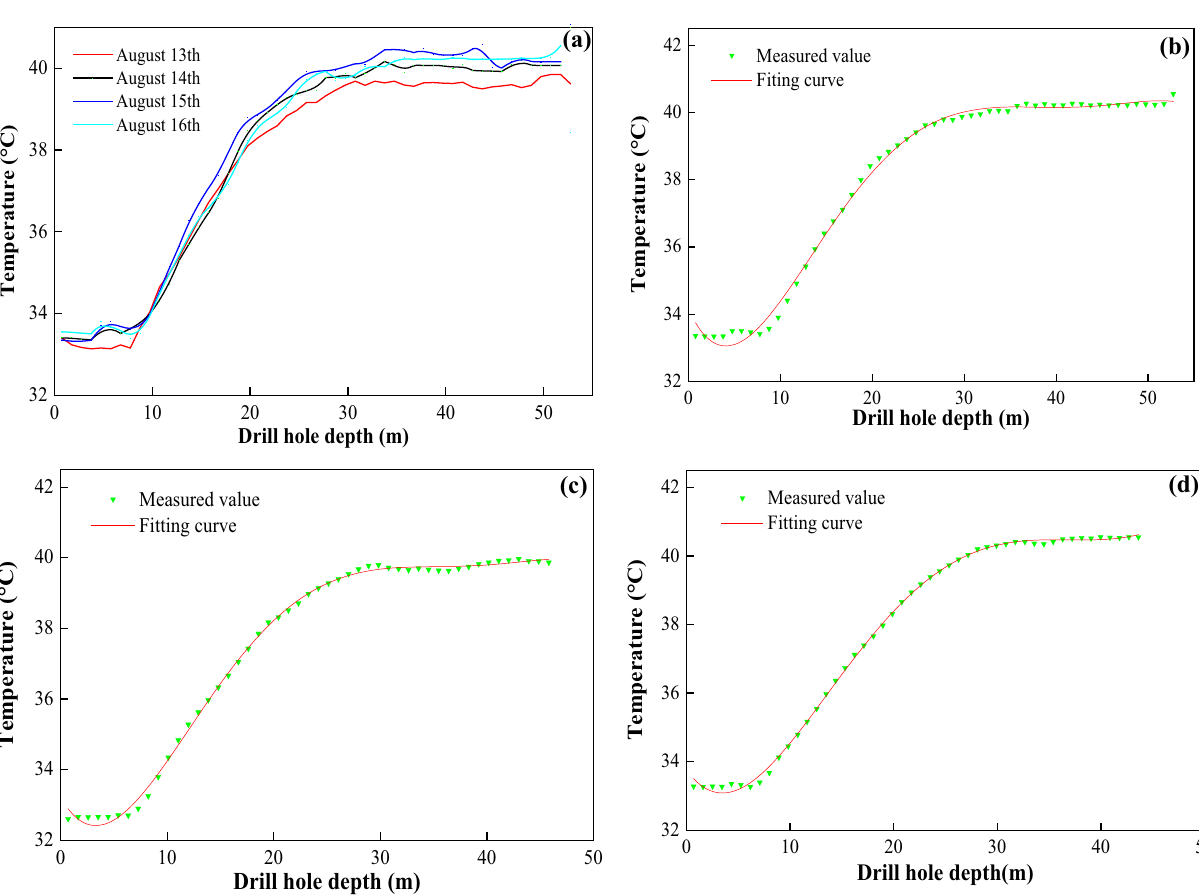
Fig. 9 Correlation curves of hole depth versus surrounding rock temperatures measured in boreholes: a measuring point at Coal Seam 1, b temperature and fitting curve of Coal Seam 1, c temperature and fitting curve of Coal Seam 2 and d temperature and fitting curve of Coal Seam